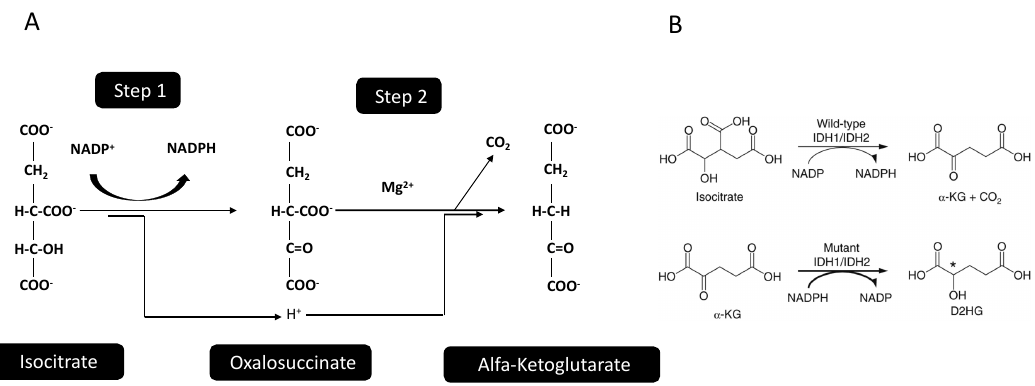
Figure 2. Enzymatic reactions catalyzed by wild-type and mutant IDH1 and IDH2 enzymes. ( A ) Normal IDH1 and IDH2 enzymes catalyze a two-step reaction. In the first step, isocitrate is oxidized to an unstable intermediate compound (oxalosuccinate), with concomitant reduction of NADP + to NADPH. In the second step, the oxalosuccinate loses its beta-carbonyl group, which is released as CO 2 , giving rise to the formation of α -ketoglutarate ( α -KG). The two H + atoms generated during conversion of isocitrate to oxalosuccinate are used for NADP + reduction to NADPH and for conversion of oxalosuccinate to α -KG. ( B ) Mutant IDH1 and IDH2 enzymes catalyze the reductive conversion of α -KG to (R)-2-hydroxyglutarate (D-2-HG) with concomitant oxidation of NADPH to NADP + . α -KG and D-2-HG are very similar from a structural point of view and differ only for the replacement of the ketone group present in α -KG, with the hydroxyl group present in D-2-HG.